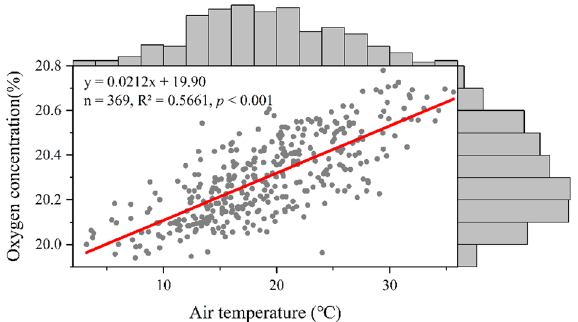
Figure 5. Scatter plot and linear fitting of oxygen concentration and air temperature (winter samples excluded) 16 . The upper and right histograms depict the frequency distribution of air temperature and oxygen concentration, respectively.